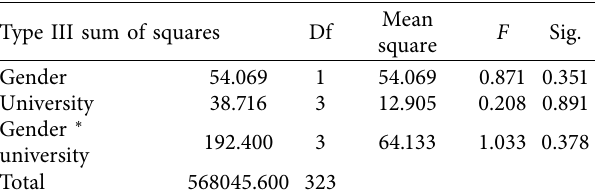
Table 3: Two-way ANOVA on the influence of institutional cat- egory and gender on level of academic